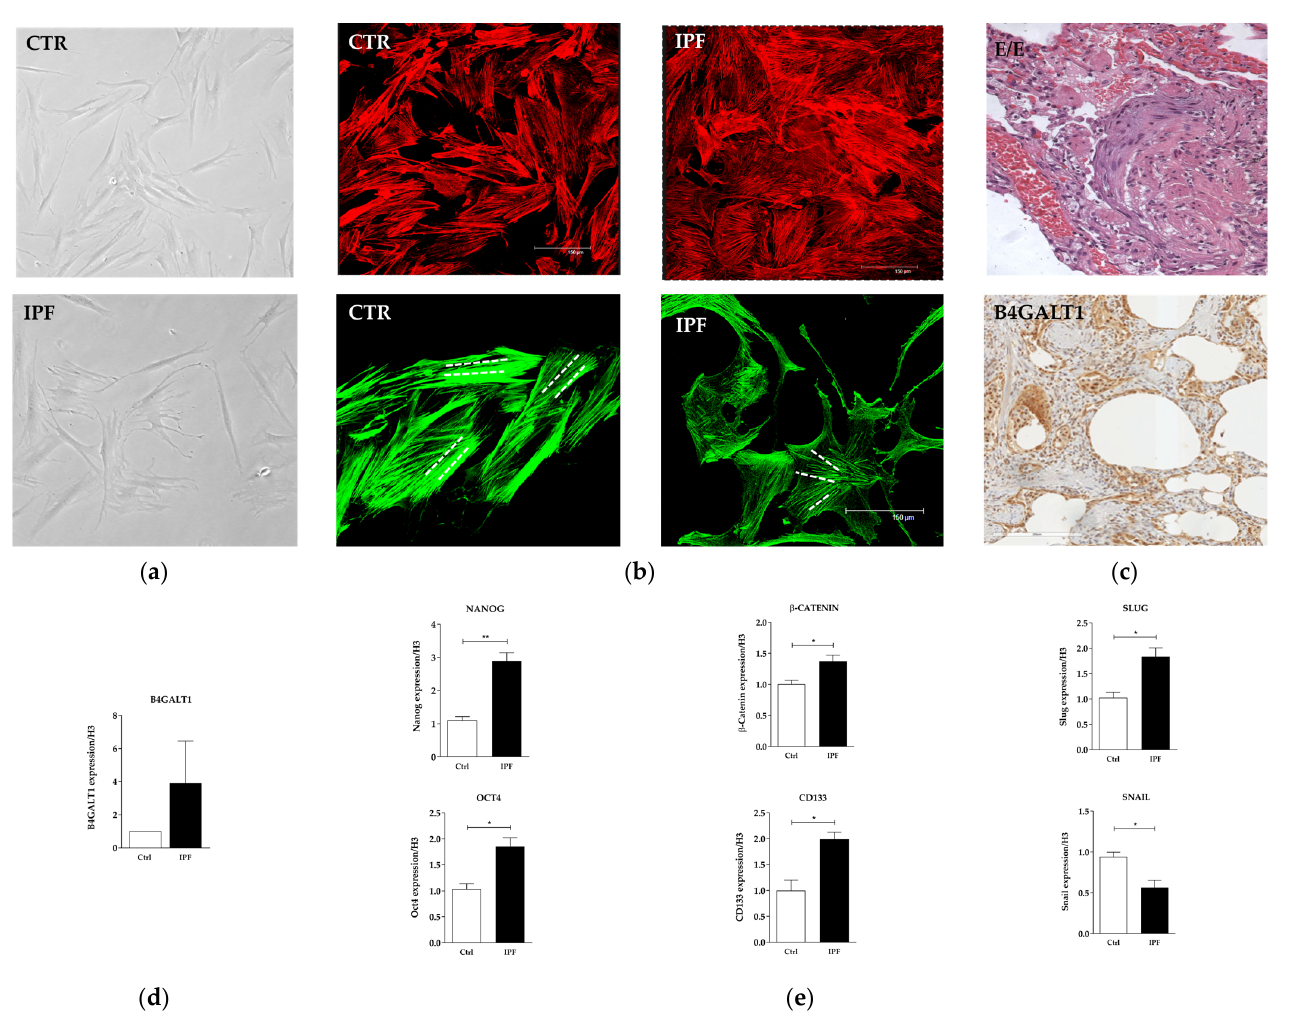
Figure 2. In Vitro characterization of IPF primary cell line. ( a ) Primary culture of human normal fibroblast (upper) and IPF (lower) (×10 magnification). ( b ) Representative bright field images on actin of normal fibroblast and IPF primary cell cultures (×40 magnification). ( c ) H&E corresponding to lung biopsy of the patient with UIP from which the primary cell culture was isolated and IHC analysis (×20 magnification). ( d ) mRNA expression level of B4GALT1. ( e ) mRNA levels of stemness genes and EMT genes between normal fibroblast and IPF verified by qRT ‐ PCR. The data are expressed as mean ± SD.* p < 0.05; ** p < 0.005.